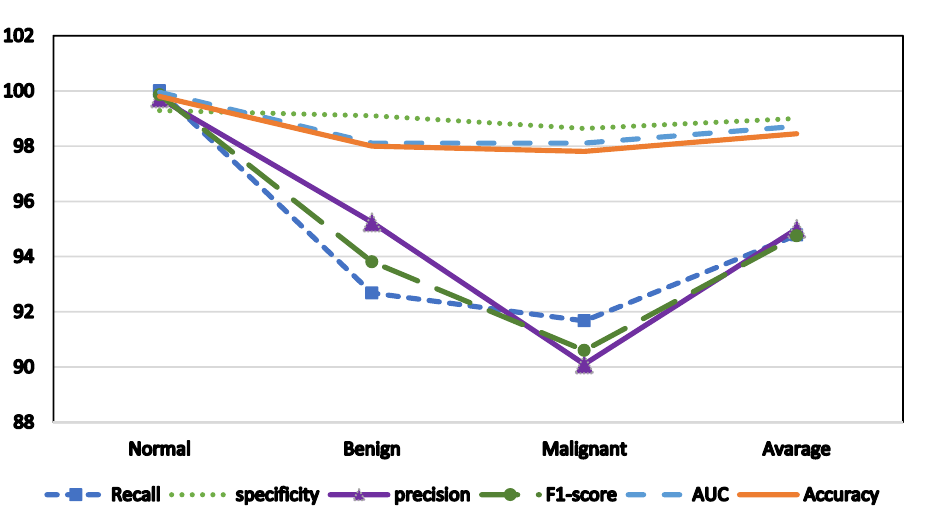
Figure 6. The proposed method average performance of all tissue